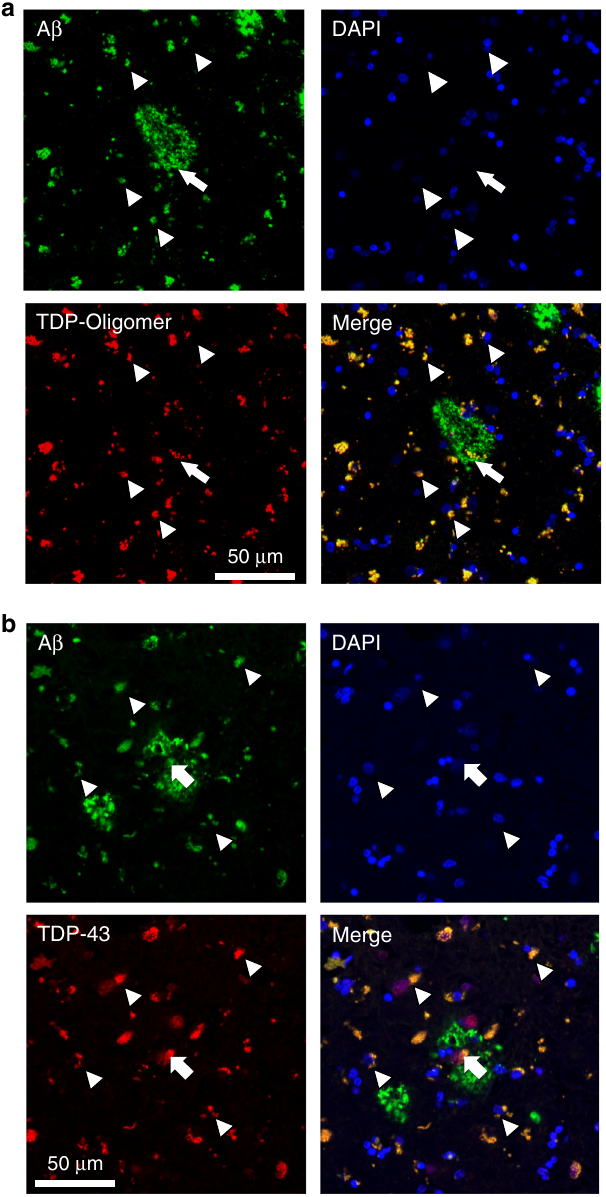
Fig. 8 TDP-43 oligomers colocalize with amyloid plaques in the brain of an AD patient. a Representative immunostaining micrographs reveal that TDP-43 oligomers mainly colocalized with intraneuronal A β (arrowhead) and partly with amyloid plaque (arrow). b Representative immunostaining micrographs show that both amyloid plaque (arrow) and intraneuronal A β (arrowhead) colocalized with the total TDP-43 in the entorhinal cortex of a 77-year-old patient with Braak stage IV AD. Four induvial samples were performed. Source data are provided as a Source Data fi